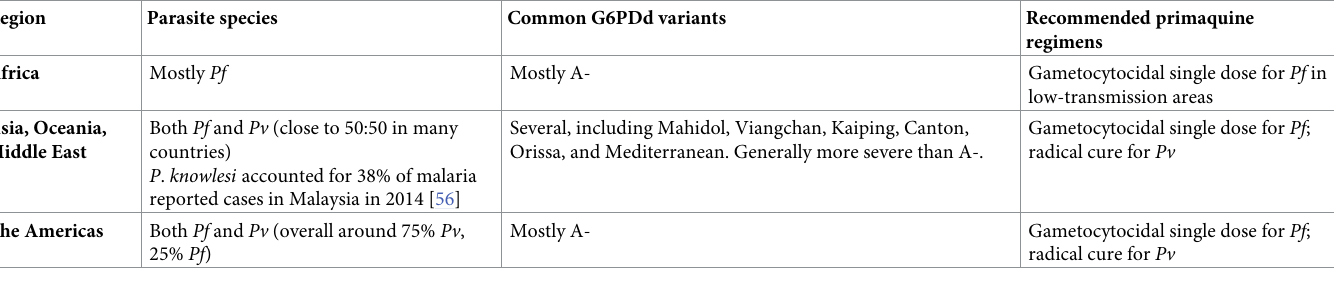
Table 3. Malaria, G6PD deficiency, and indications for primaquine in different malaria-endemic regions.